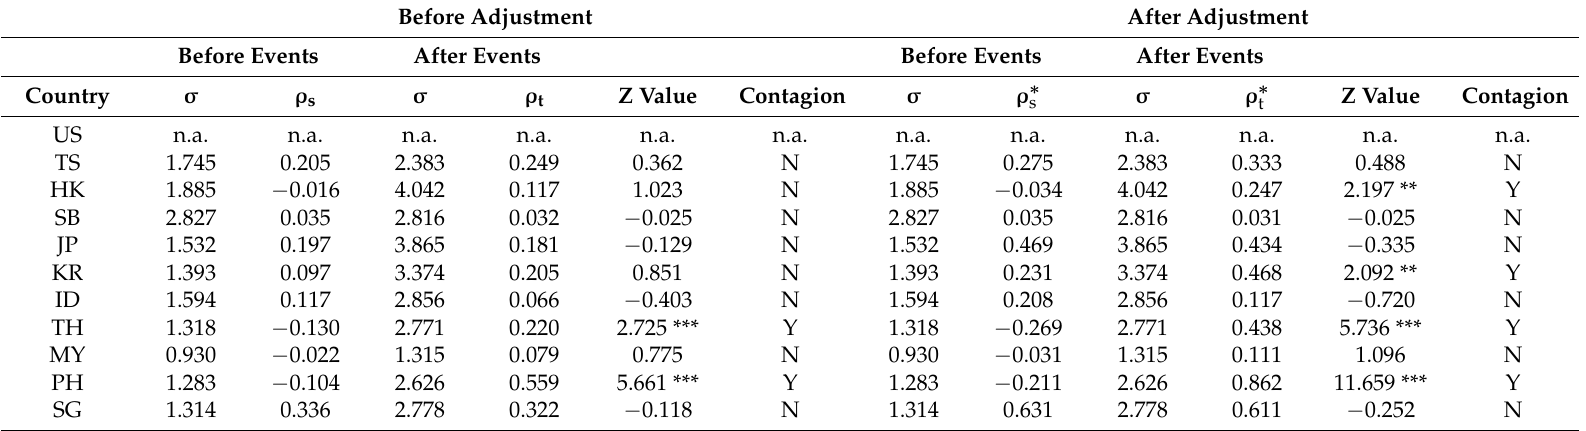
Table 9. The Correlation Coefficients after heteroscedasticity biases adjustment: global financial